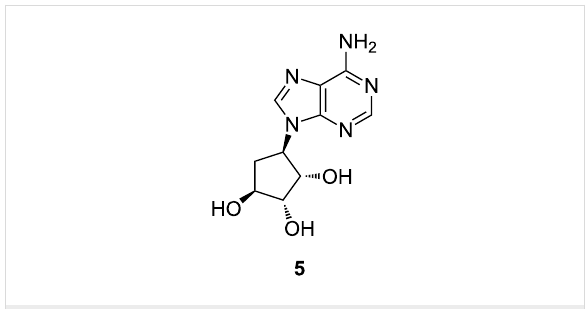
Figure 2: Chemical structure of